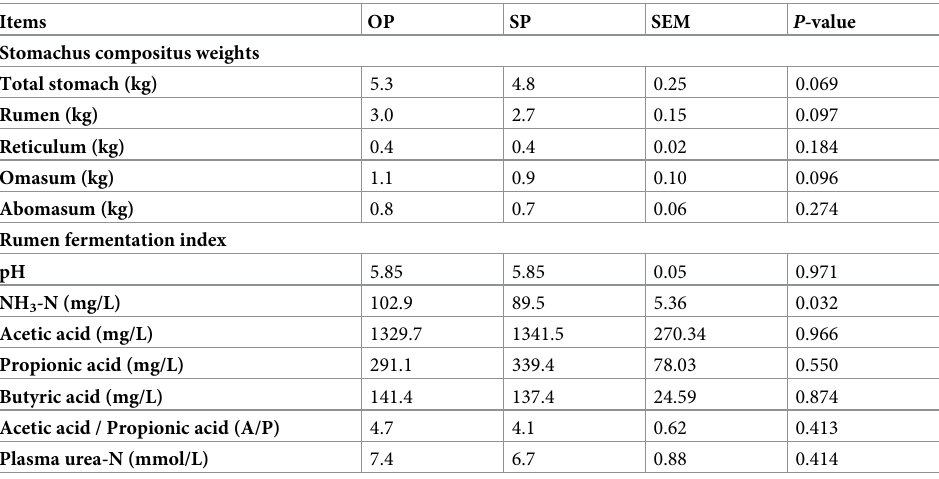
Table 2. Stomachus compositus weights and rumen fermentation index in calves fed OP and